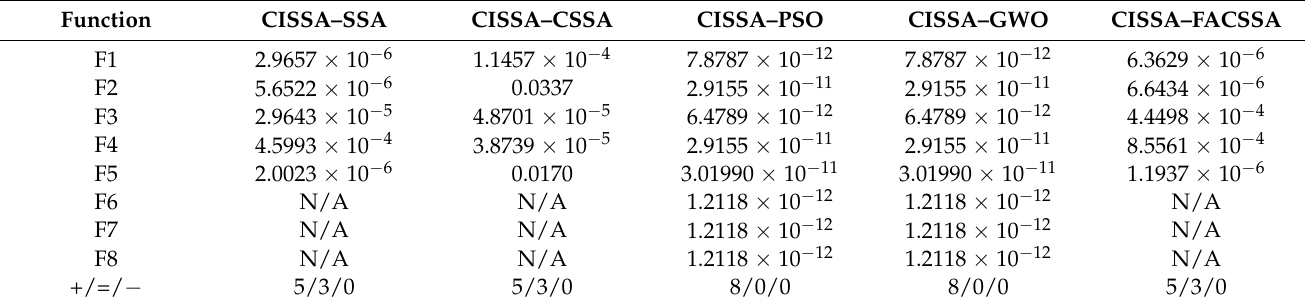
Table 5. Wilcoxon signed rank test p